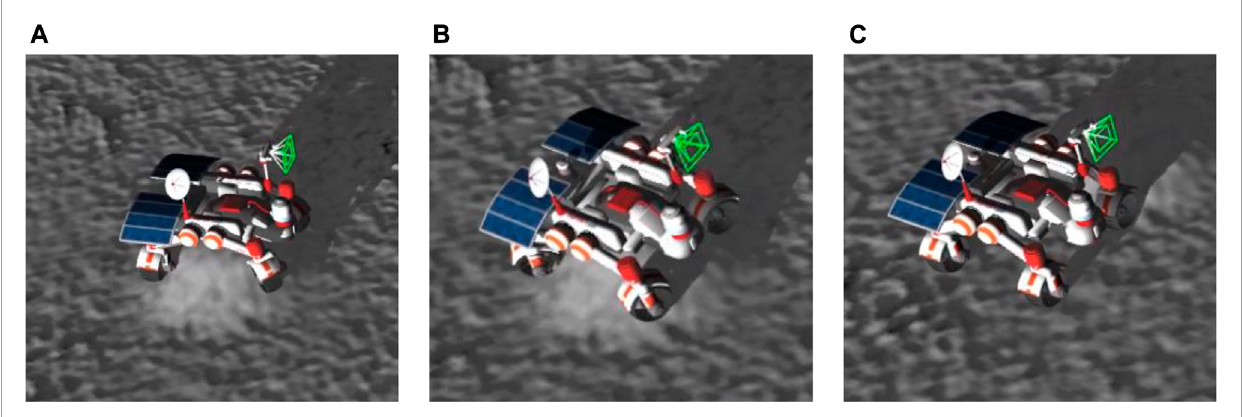
FIGURE 4 Stuck detection capability. (A) Stuck detection. (B) Recovery maneuver. (C) Mobility